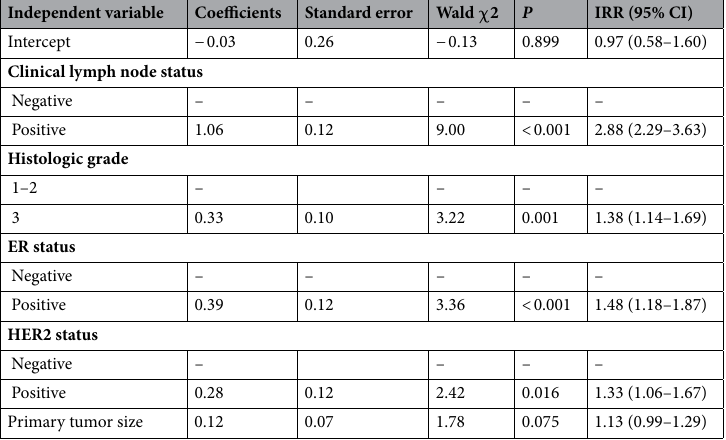
Table 3. The fitting result of negative binomial regression model. Abbreviation: CI, confidence interval; ER, estrogen receptor; HER2, human epidermal growth factor receptor 2; IRR, Incidence rate ratio.